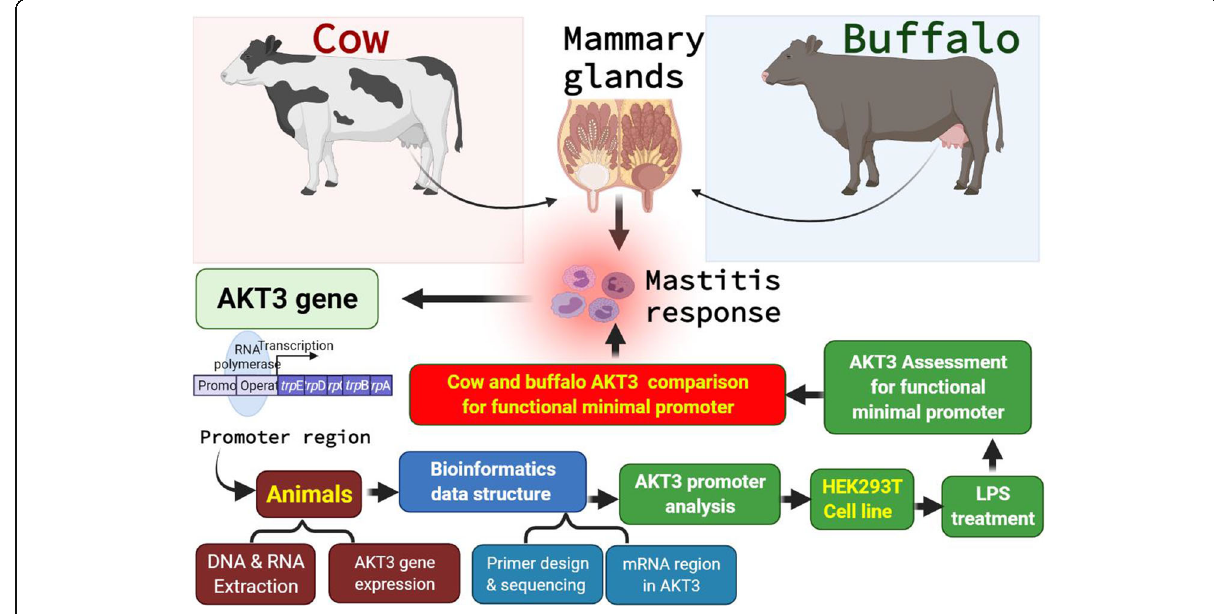
Fig. 1 Flow chart of the experimental